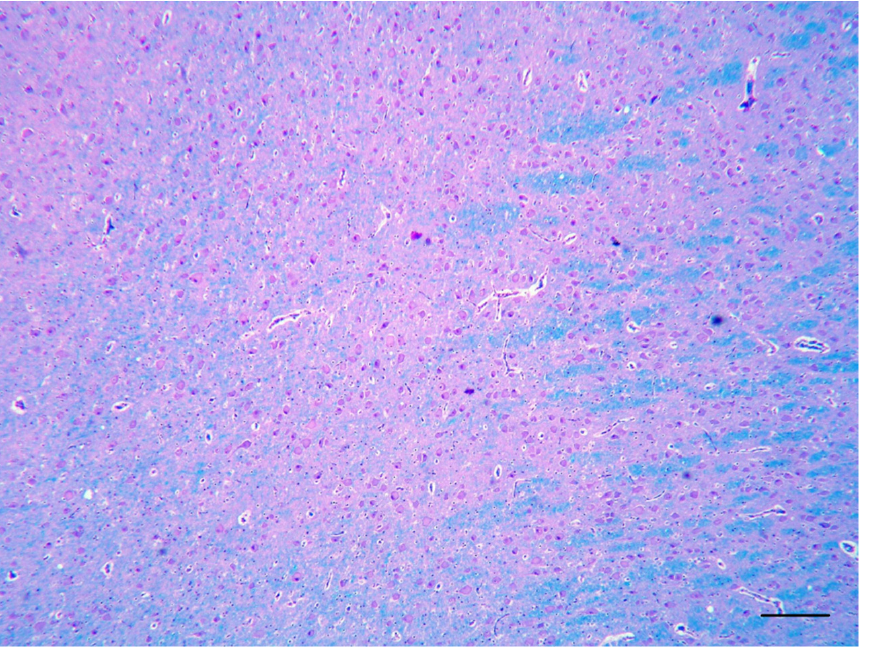
Figure 2. Telencephalon of dog 1. Numerous cytomegalic neurons are intermingled with normally conformed myelin tracts (LFB, bar = 250 μ m).